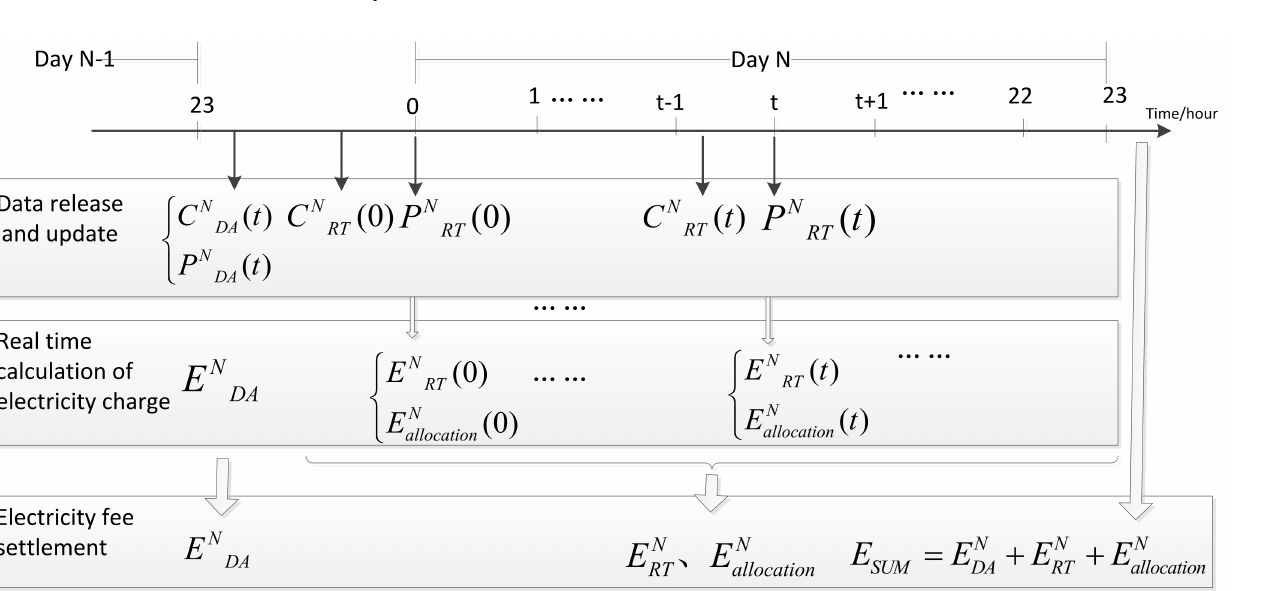
Figure 4. Time flow of electricity cost settlement in spot market. Figure reference: Guangdong Electric Power Trading Center: detailed rules for the implementation of spot electric energy market transactions in Guangdong and detailed rules for the implementation of transaction settlement in Guangdong electric power market , November